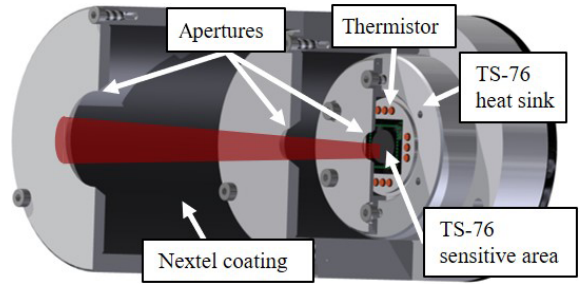
Figure 9. Inner housing with three apertures in front of the